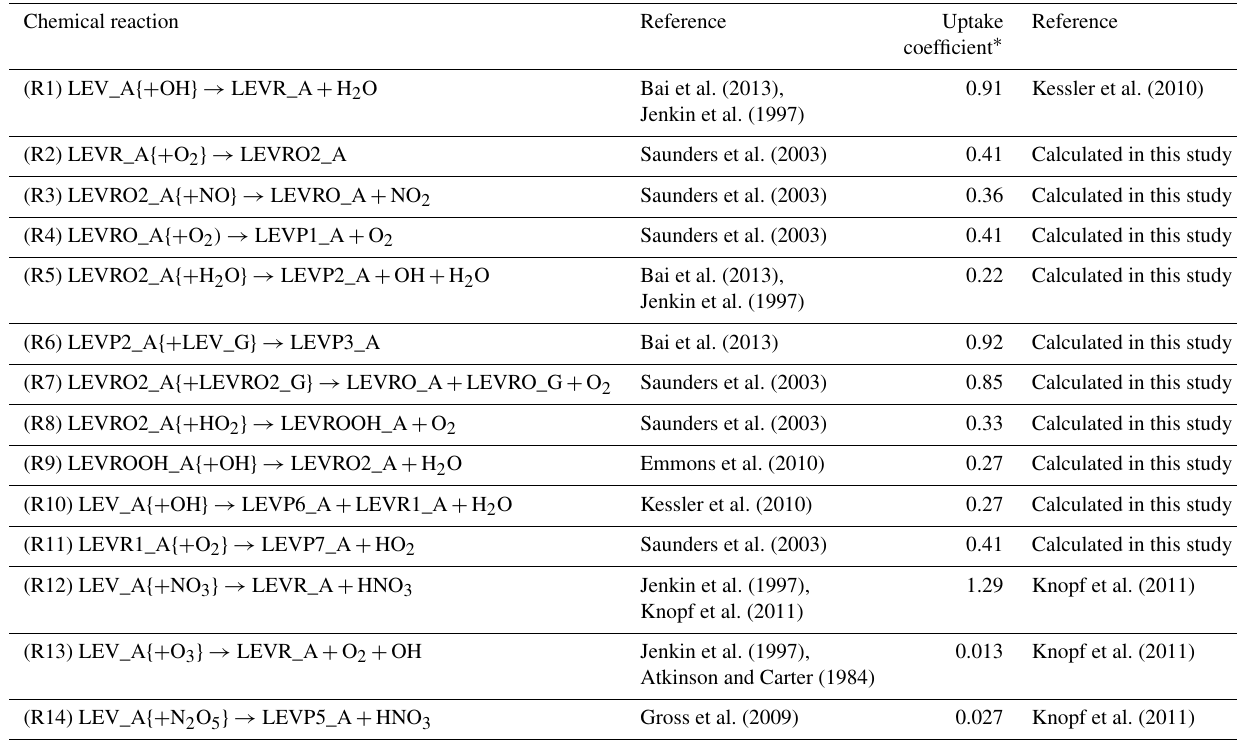
Table 2. Heterogeneous mechanism. Chemical